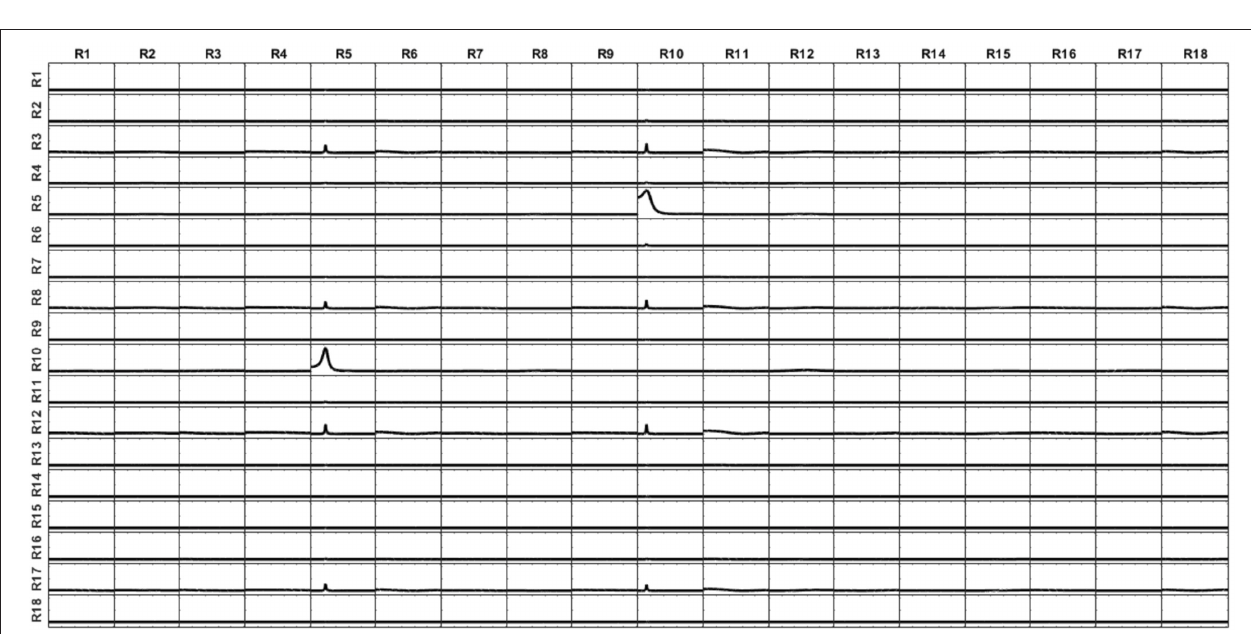
FIGURE 13 | sLoreta solution using the superficial lead field. The upper panel shows the solution for the voltage generated with the set of voxels located in the surface. The lower panel shows the solution for the voxels lying in the volume, in the inner layer next to the voxels in the surface. The source localization is not affected by the position of the sources either at the surface or immediately below the surface voxels. Only the amplitude of the solution is smaller for the voxels in the inner layer.